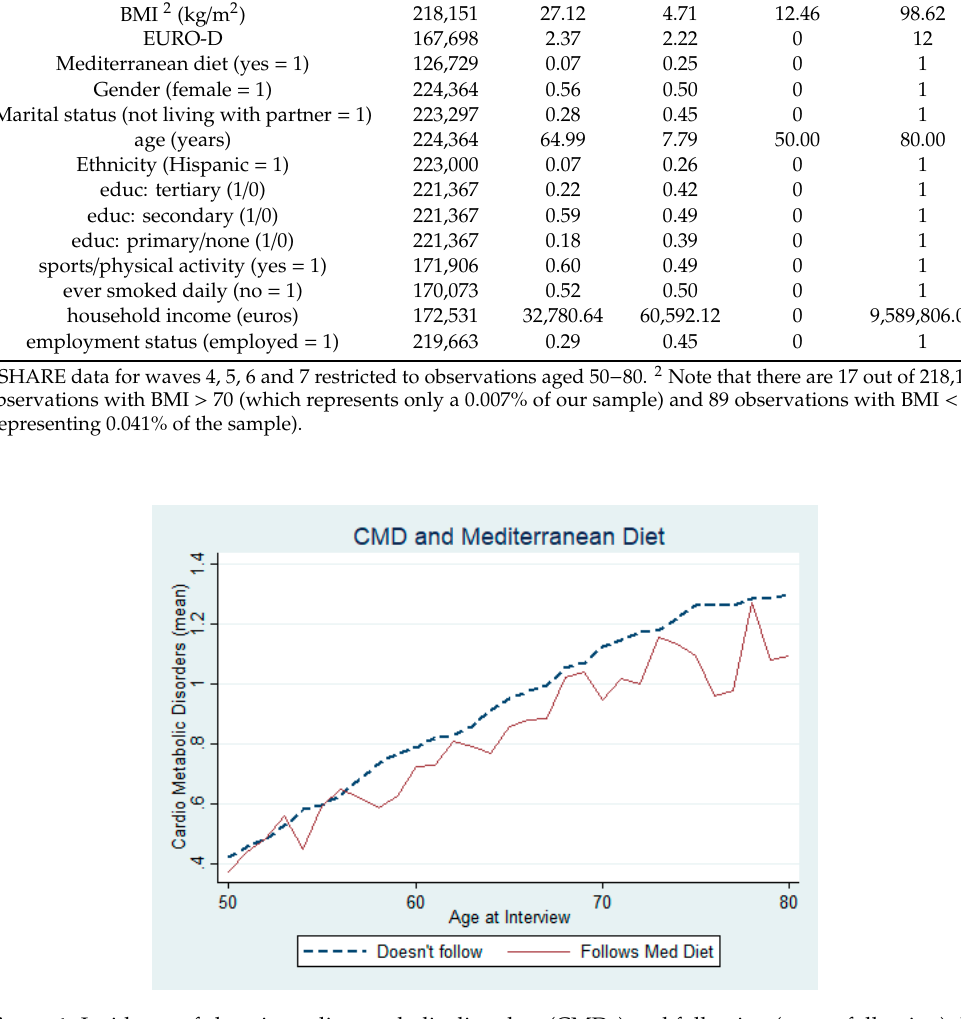
Figure 1. Incidence of chronic cardio metabolic disorders (CMDs) and following (or not following) the Mediterranean diet.